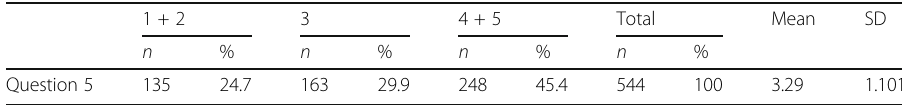
Table 10 Impact on students ’ English learning